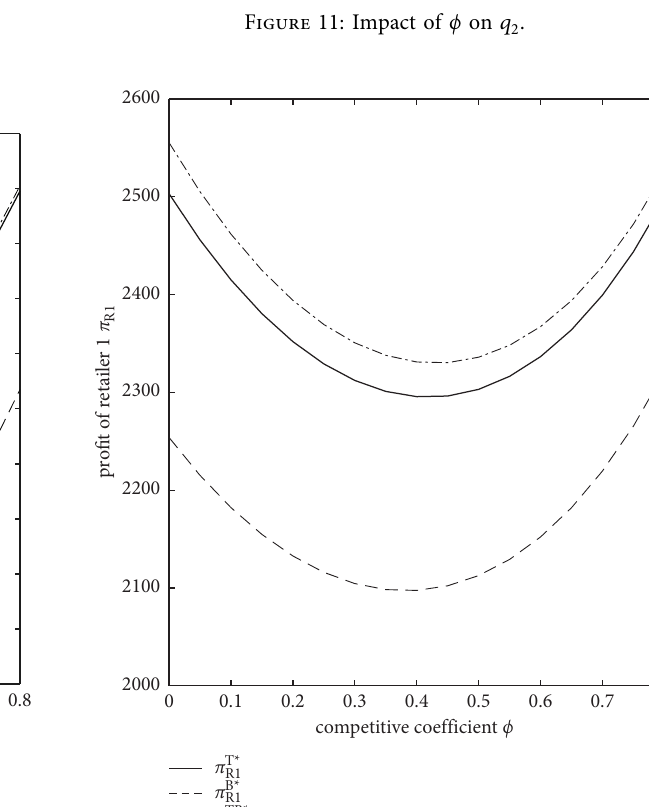
Figure 9: Impact of ϕ on e .